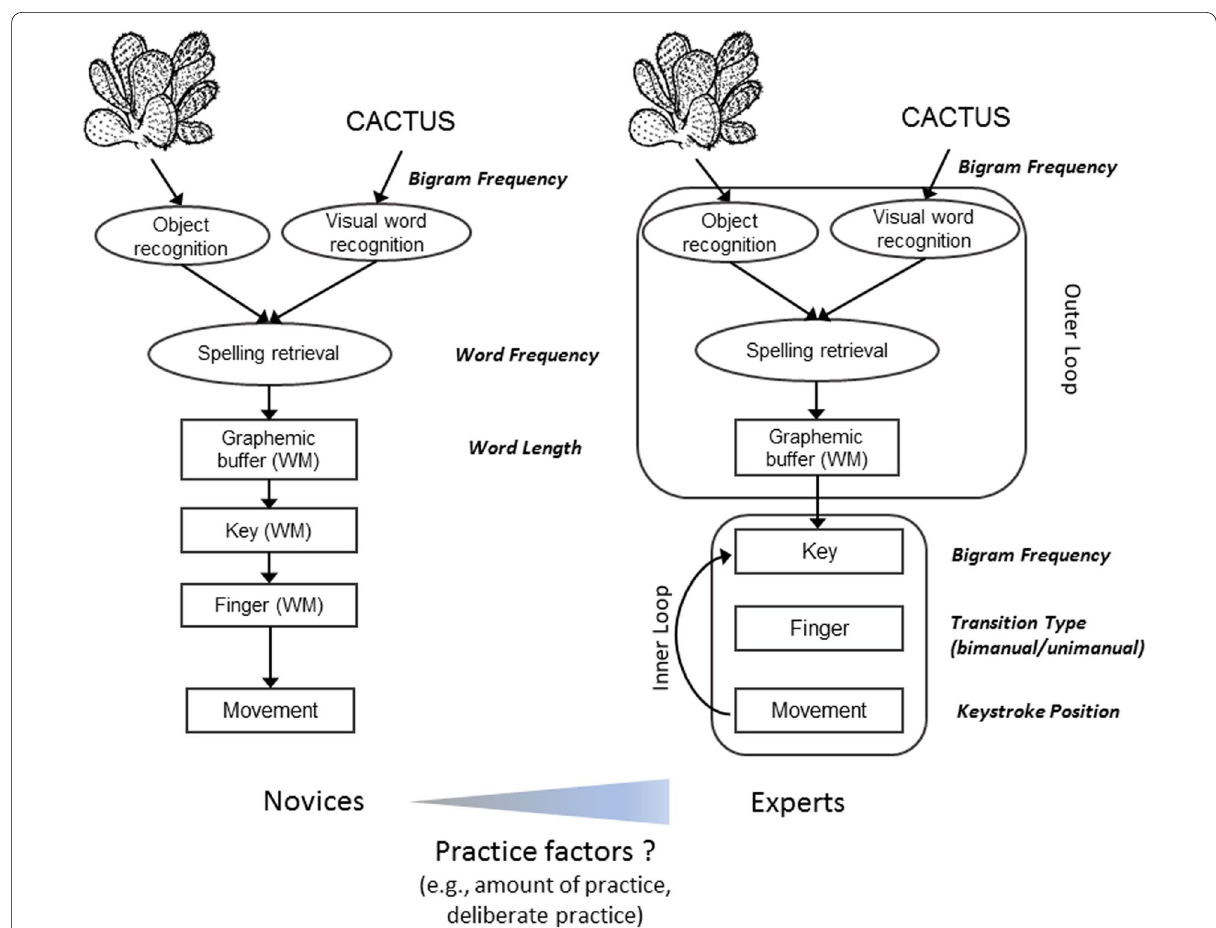
Fig. 2 Cognitive steps of word production in novice and expert typists. Experimental variables manipulated and their hypothesized locus are depicted in bold italics. Within this framework, our main assumption is that factors of the typed material that target the motor structure of the sequences of keystrokes should impact differently the performance of the most and least proficient typists of the sample, whereas factors that affect earlier stages of language production should have a similar effect on the performance of both groups of typists. Word frequency and word length should modulate reaction times; bigram frequency, transition type, and keystroke position should modulate IKIs, and bigram frequency should modulate reaction times only in the copying task. Figure freely adapted from Alario et al., (2004), Bonin et al. (2003), and Logan and